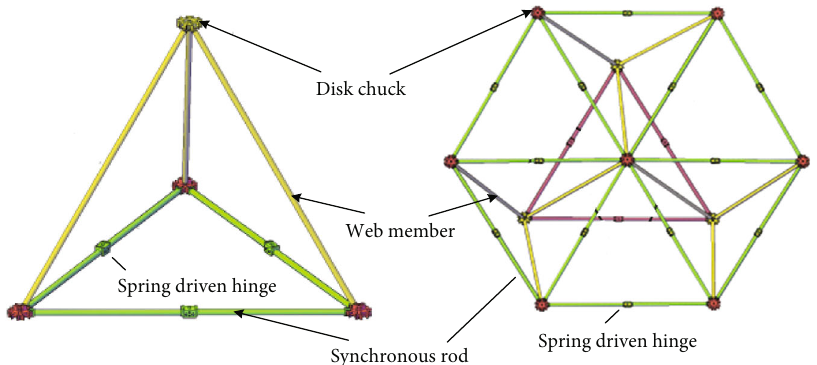
Figure 3: Tetrahedral element and its geometric extension structure.